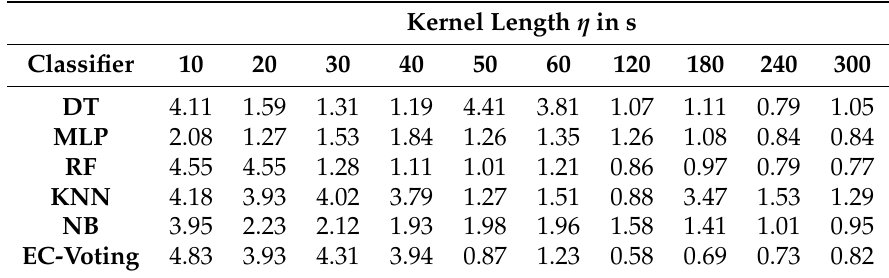
Table 6. Standard deviations at different kernel lengths by different classifiers in Context 1, Scenario 2.